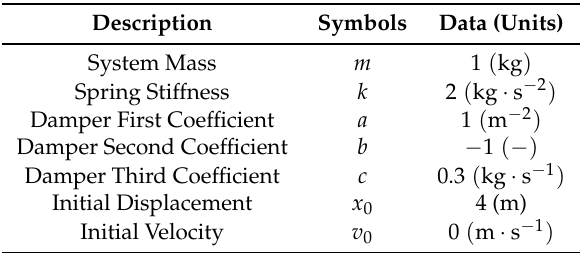
Table 1. Nonlinear oscillator numerical